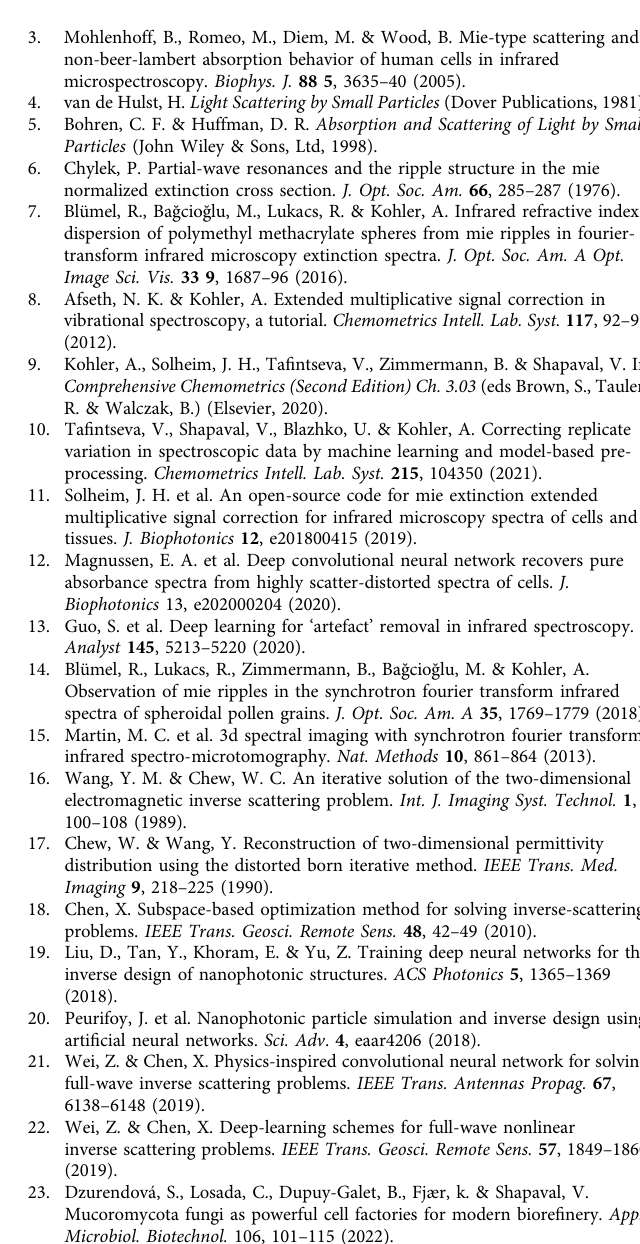
Fig. 6 FPA spectral data of fi lamentous fungi. a The FPA image of several Mucor circinelloides fungal cells with the fungal cell under consideration in the colored squares. The hyperspectral image is shown for ~ ν ¼ 1745cm (cid:2) 1 . b The mean spectra of fi ve fungal cells in the FPA image. The colors of the squares in ( a ) correspond to the colors of the spectra in (